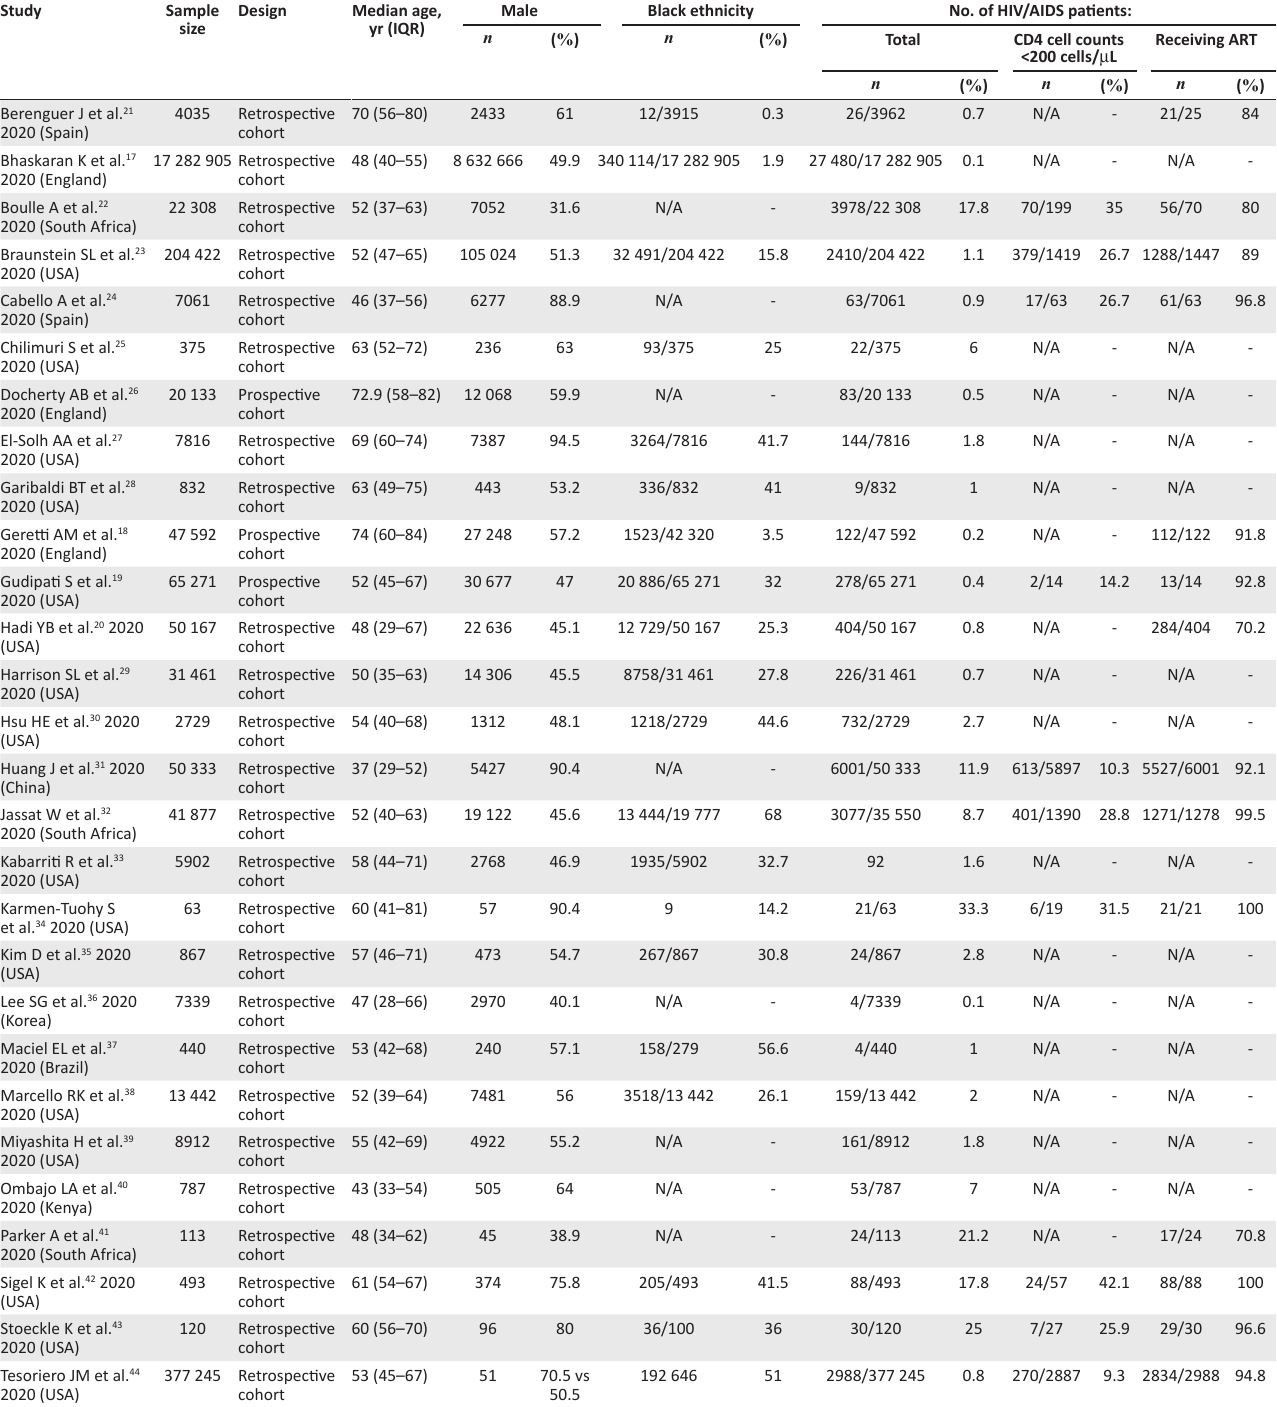
TABLE 2: Characteristics of the included